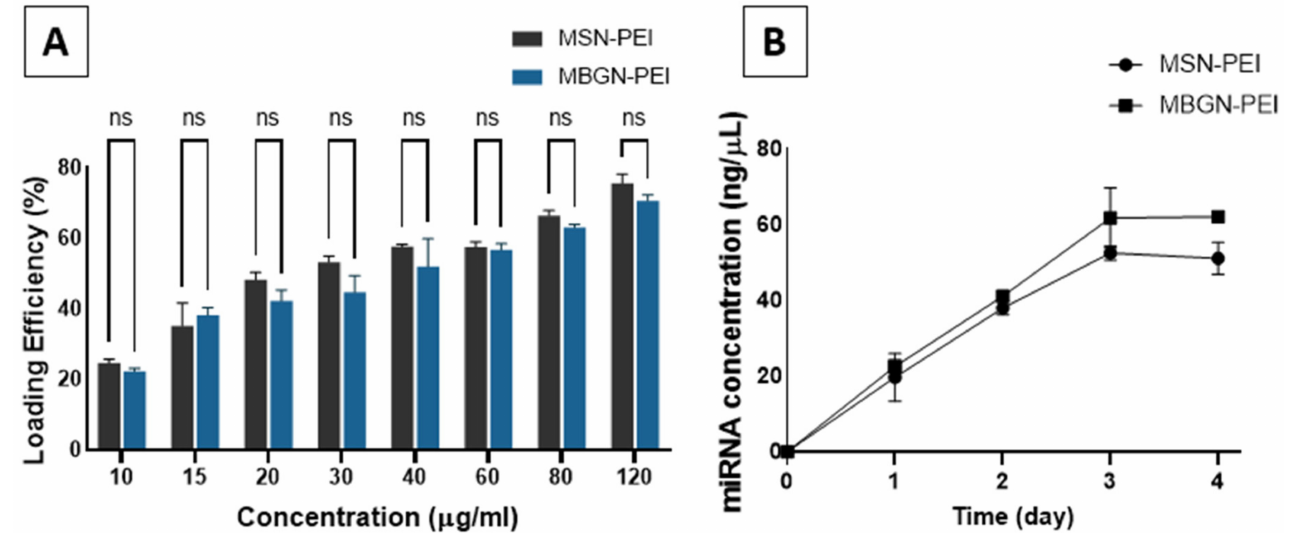
Figure 3. The loading efficiency ( A ) and the release profile ( B ) of MSN-PEI and MBGN-PEI for miRNA. A continual release for up to 3 days was observed for both groups with a final quantity of approximately 51% and 62% of the initial loading for MSN and MBGN groups, respectively, and then almost saturation. ns means there was no significant difference by post hoc Tukey tests ( n =